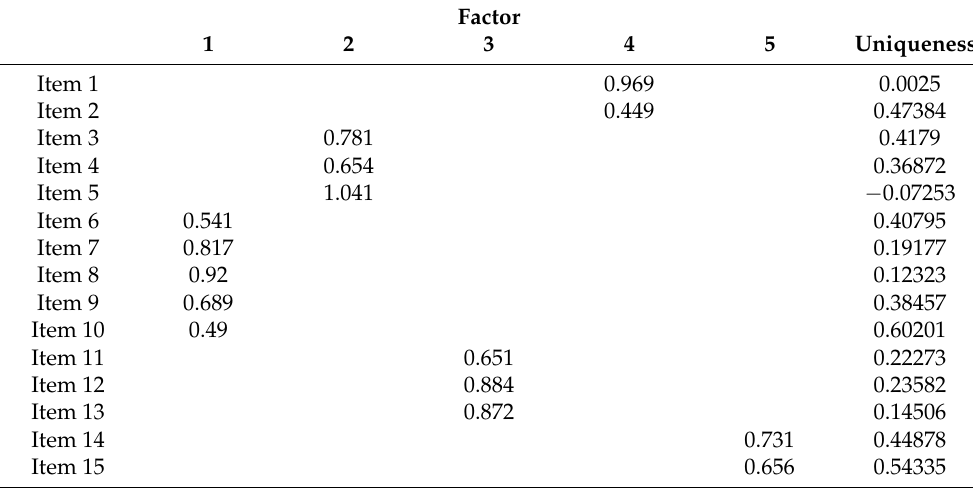
Table 3. Confirmatory factor analysis, factor